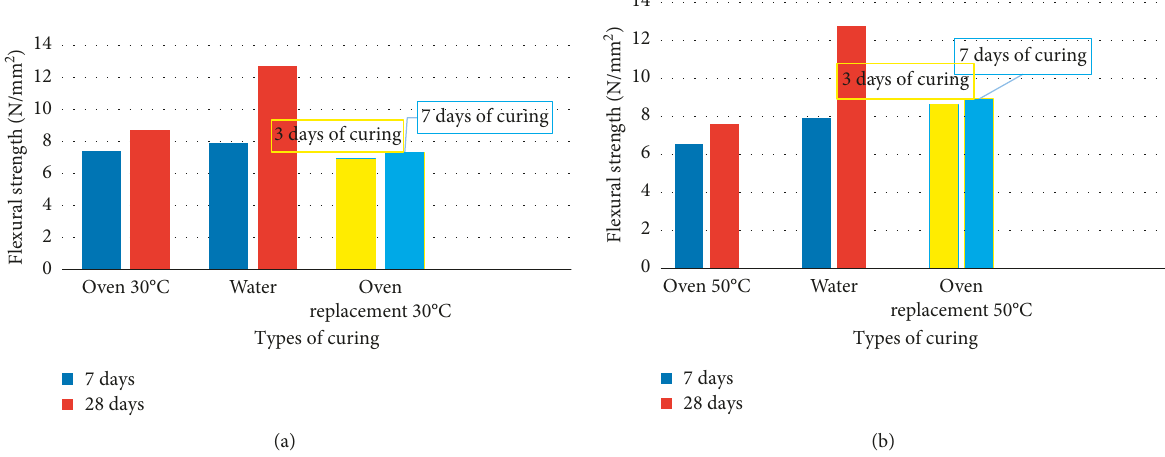
Figure 4: Flexural strengths of concrete specimens with a W/B ratio of 0.3 prepared and cured under different conditions at a temperature of (a) 30 ° C and (b) 50 ° C.